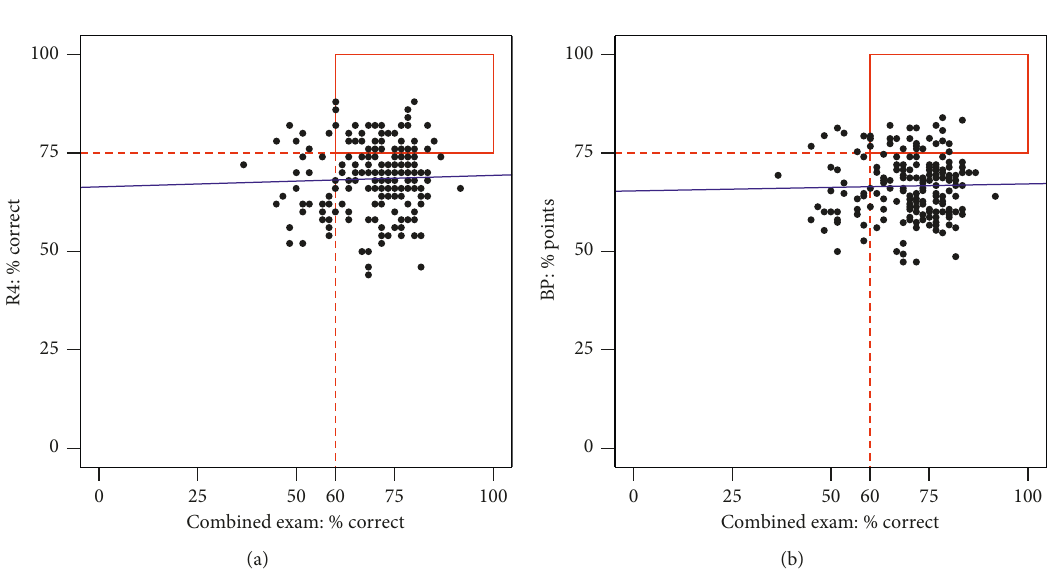
Figure 8: Performance of the year 2014 students. Performance of the 2014 R4 group with alternative scoring (panel (a)) and bonus point scoring (panel (b)) in the combined regular exams versus their performance in the additional questions. Each dot represents the scores of a single examinee with dots in the upper right rectangle being the ones that passed both exams. Dotted lines indicate scores required for passing. The straight line represents the linear fit to the data.